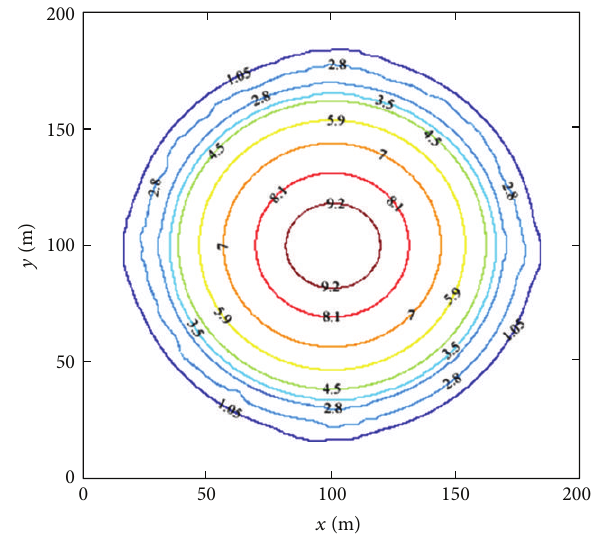
Figure 12: 2D Circular dam break water depth contours obtained using V-Break.